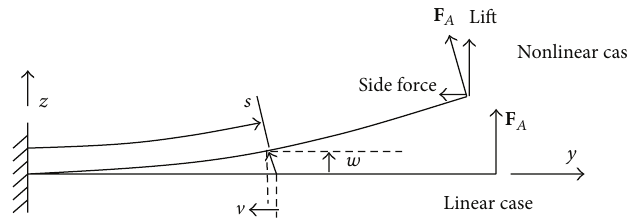
Figure 12: Aerodynamic force in linear and nonlinear